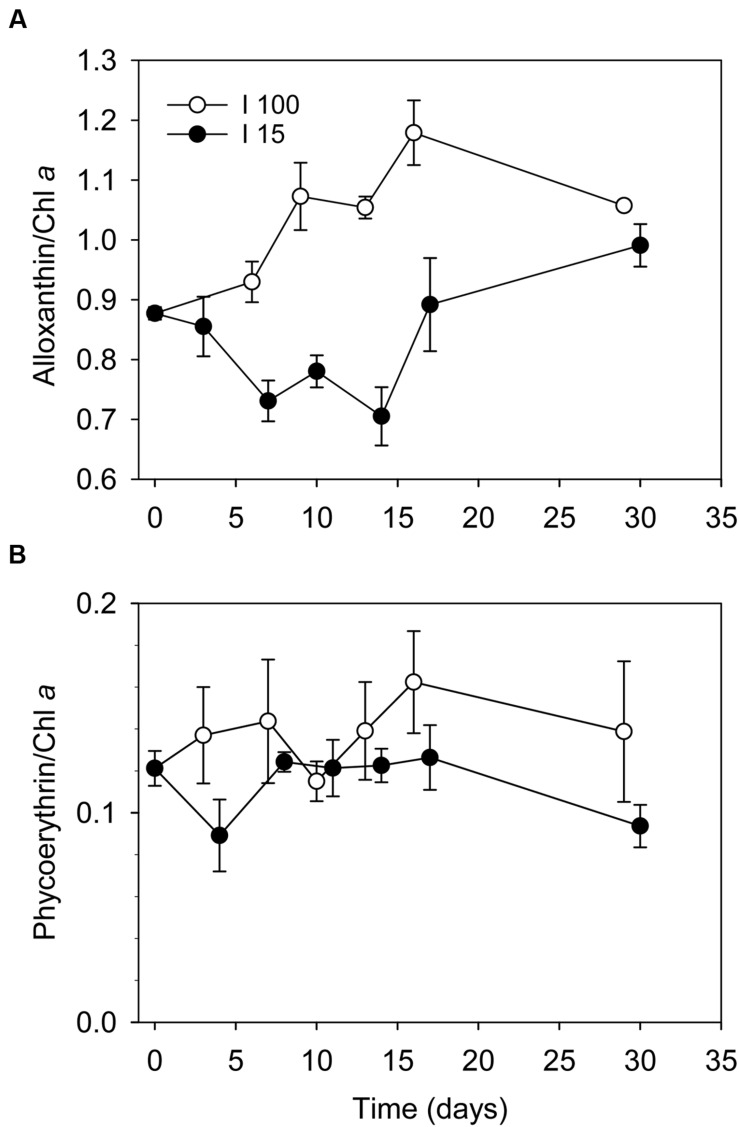
Changes in the ratio of (A) alloxanthin:Chl a ratio, and (B) phycoerythrine:Chl a ratio in D. acuta cells during the starvation experiment under irradiances of I100(o) and I15(●), respectively. Data points represent treatment means, and error bars indicate standard errors (n = 3).